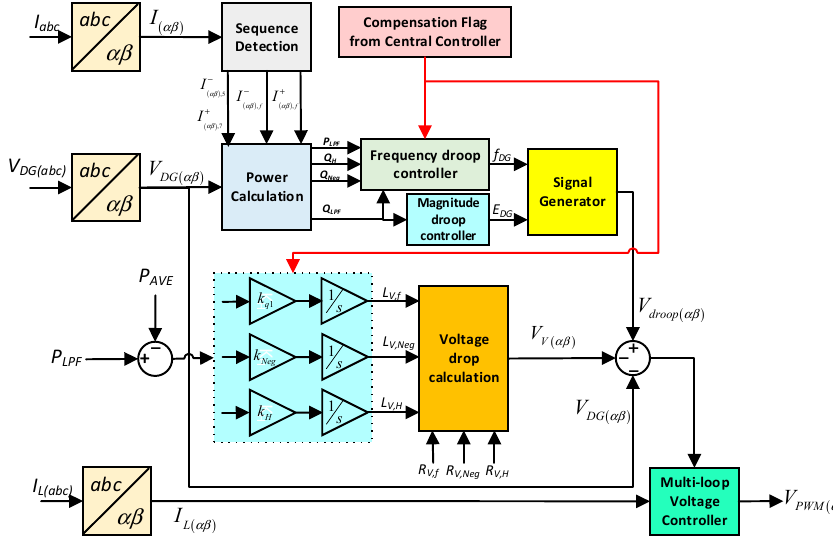
Figure 10. Block diagram of the control method of [104].